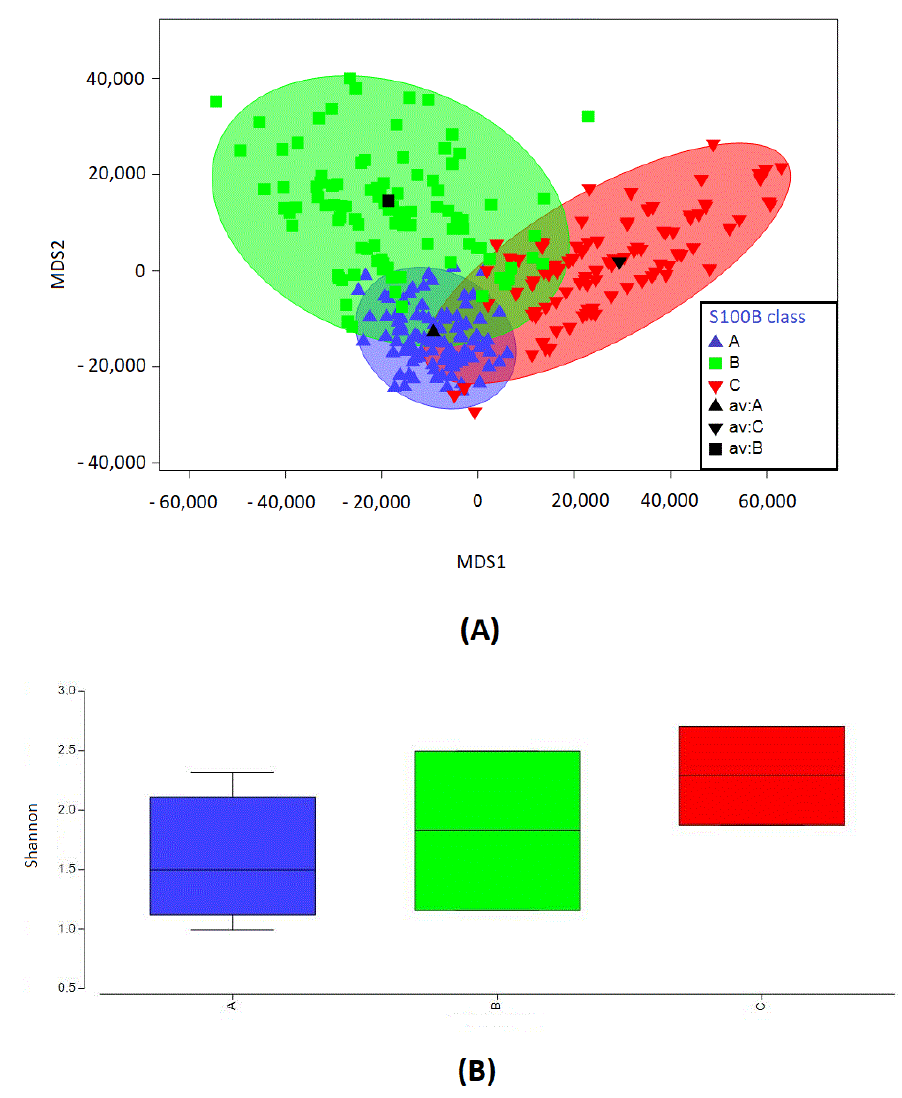
Figure 3. ( A ) Correlation between S100B levels and the microbiota biodiversity clusters samples into 3 groups. Bootstrap average analysis of the microbiota composition in relationship with levels of S100B (A = lower than 1.75 ng/mL, B = between 1.76 and 2.4 ng/mL, C = higher than 2.5 ng/mL). ( B ) Shannon index values with respect to S100B clusters. Box plots represent the distribution of calculated Shannon index for microbiota samples based on the different levels of S100B (A = lower than 1.75 ng/mL, B = between 1.76 and 2.4 ng/mL, C = higher than 2.5 ng ml).